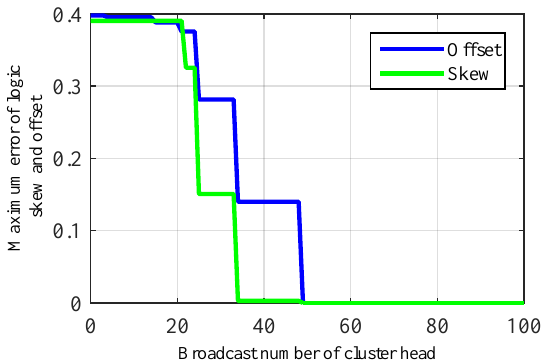
Figure 6. Comparison between skew and offset by using CMTS in inter-cluster time synchronization.